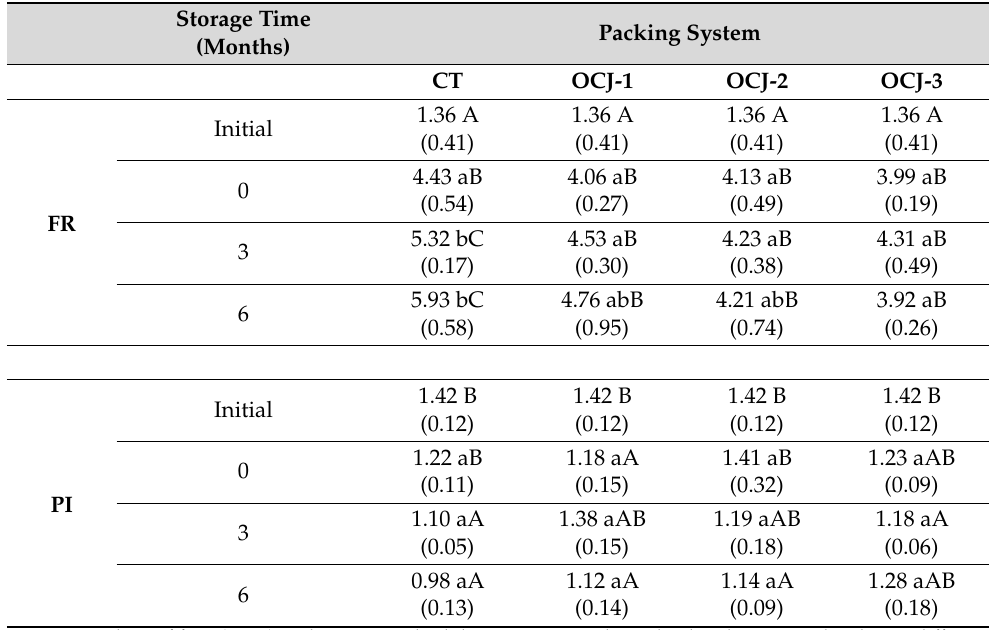
Table 2. Determination * of fluorescence ratio (FR) and polyene index (PI) in initial and canned horse mackerel previously subjected to frozen storage and canned with different packing systems